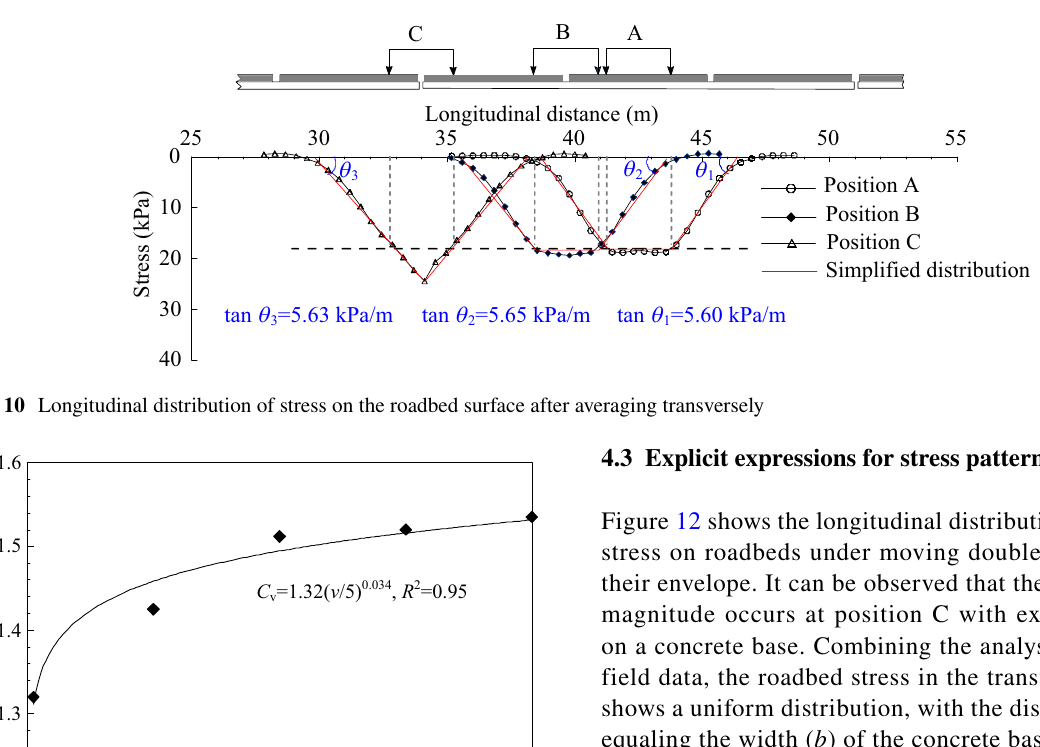
Fig. 9 Longitudinal distribution of stress on roadbed at different lateral positions: a track center; b under the rail; c edge of concrete base